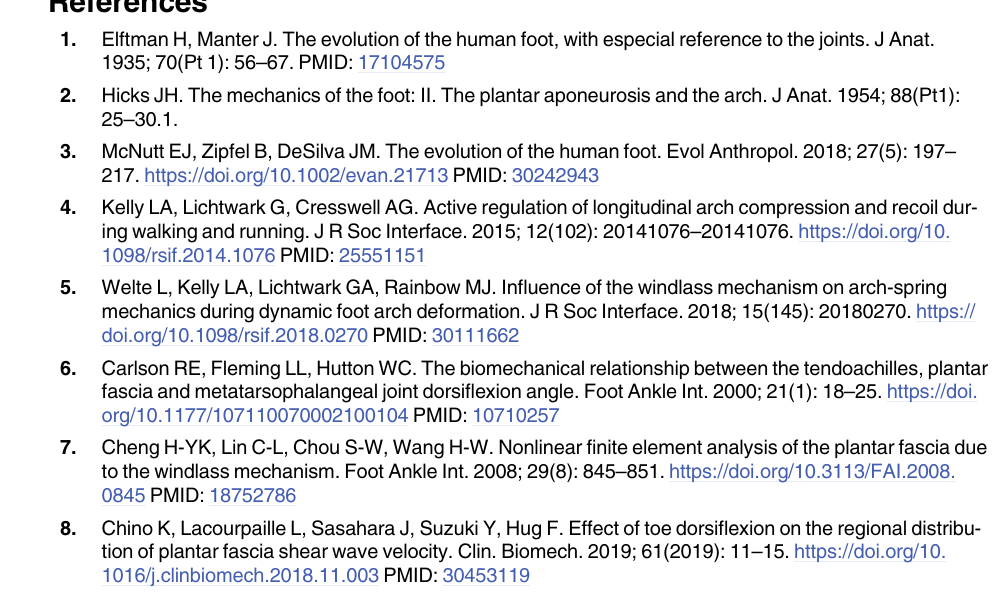
Horizontal bars top of the left panel indicate the timing of a statistically significant time-series differences between the control and toe-wedge conditions using a two-tailed paired t-test ( α = 0.017 after Bonferroni correction). The top (purple) horizontal bar indicates a difference between control and toe-wedge conditions, the middle (black) bar represents a difference between the control and added mass conditions, and the bottom (black with purple outline) bar denotes a difference between the toe-wedge and added mass conditions. S1 Table. Impulse values determined from ground reaction force-time profiles. Values rep- resent mean ± standard deviation and are normalized to total mass in each condition. S2 Table. Dimensionless joint mechanical work. Values represent mean ± standard deviation and are normalized to the product of body mass, acceleration due to gravity, and leg